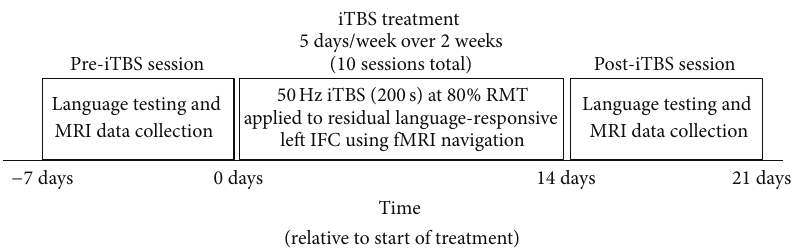
Figure 1: Experimental timeline. Patients underwent language testing and MRI scans during the week prior to treatment. Patients then received one session of iTBS each on weekday over a two-week period and underwent language testing and MRI scans again during the week following